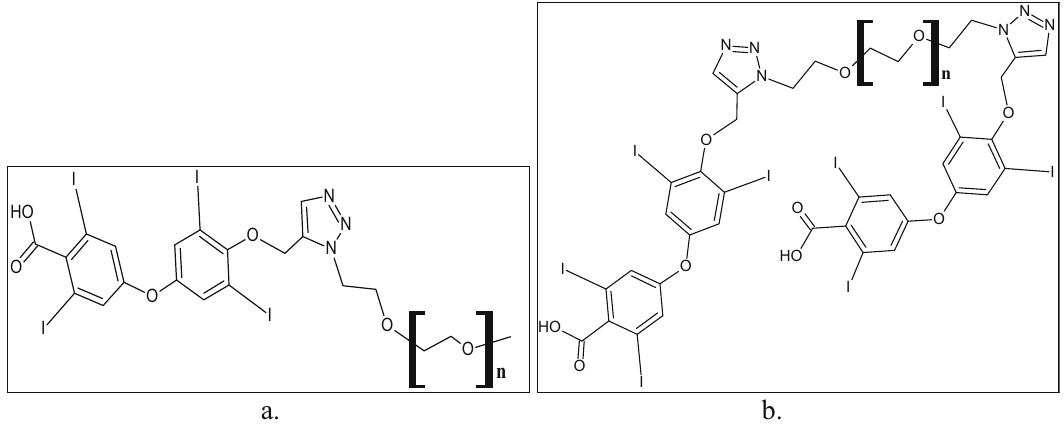
Figure 8: Chemical structures of PEG ( polyethylene glycol ) conjugated Tetrac: ( a ) PEG - conjugated one Tetrac unit conjoined through single triazole unit ( PEG - triazole - Tetrac, P - mono - TAT ) ; ( b ) two Tetrac units ) conjoined through distantly placed two triazole structures ( Tetrac - triazole - PEG - triazole - Tetrac [ P - bi - TAT ]) ; n means the average number of repeating oxy ethylene units ( 90 ) of the polymer PEG, PEG A V MW